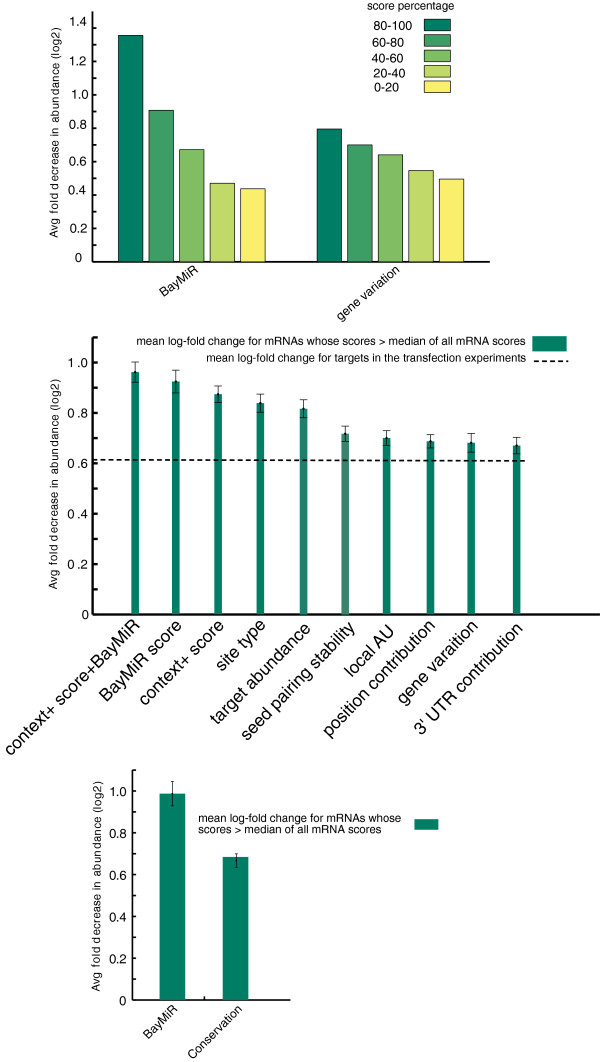
BayMiR performance in the miRNA over-expression experiments. (top) mRNAs in the over-expression miRNA assays are grouped into five bins based on their BayMiR and gene variation scores; the mean log-fold change of the mRNAs in each bin is plotted in as a bar. There are two groups of bars; the left- and right-hand groups correspond to BayMiR and gene variation, respectively. (middle) Comparing BayMiR and gene variation scores with seven sequence scores from TargetScan. Each bar represents the negative mean log-fold change for mRNAs whose scores are greater than the median of all mRNA scores for the selected determinant in the miRNA over-expression assays. The most left-hand group is obtained by combining the context+ scores with BayMiR scores. The dashed line shows the mean log-fold change for all targets in the miRNA over-expression assays (bottom) Comparing BayMiR scores with the conservation scores as measured by TargetScan. The conservation scores are given only for the targets with conserved target sites complementary to the seed regions of the conserved miRNA families. Error bars indicate 95% confidence intervals for the estimated means.